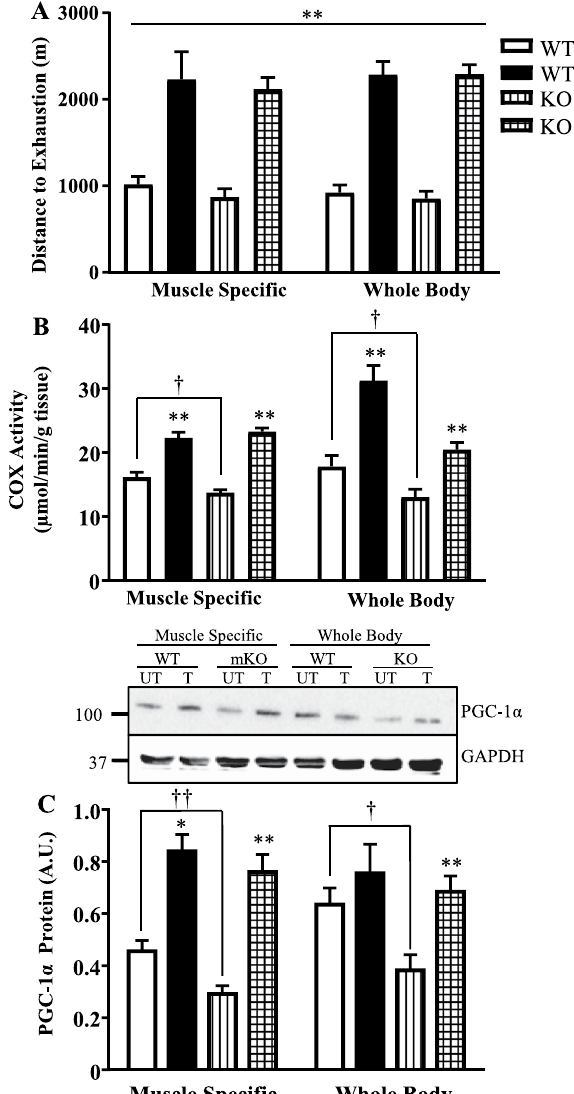
Figure 7. Adaptive mitochondrial responses with training in two mouse models. Following the 6-week training/sedentary protocol, the WT and muscle-specific (mKO) and whole-body (WB) p53 knockout mice were subjected to an exhaustive exercise test. ( A ) Distance to exhaustion in both mouse models (n = 6–9/ group); ** p ≤ 0.01, UT vs. T, 2-way ANOVA. ( B ) COX activity (n = 6–8/group); ** p ≤ 0.01, UT vs. T, Student’s t-test and 2-way ANOVA; † p ≤ 0.05, UT WT vs. KO, Student’s t-test. C ) PGC-1 α protein (n = 5–10/group); * p ≤ 0.05, ** p ≤ 0.01, UT vs. T, Student’s t-test and 2-way ANOVA; † p ≤ 0.05, †† p ≤ 0.01, UT WT vs.